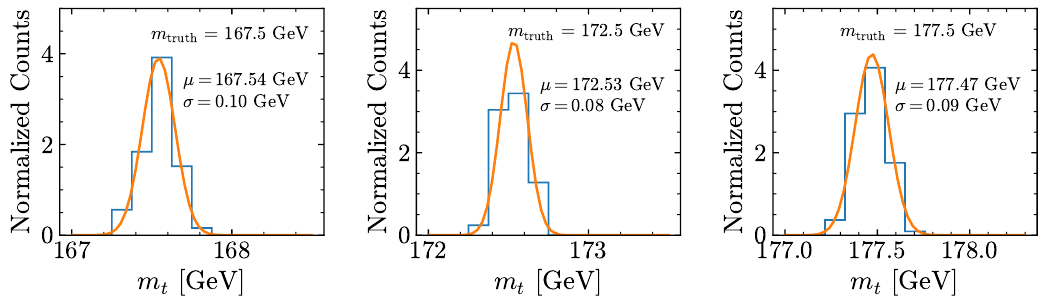
Figure 20 . The semi-leptonic template closure tests for m t =167.5 GeV, 172.5 GeV and 177.5 GeV, using our modi(cid:12)ed approach. The distribution of bootstrapped results are given by the histogram, along with an accompanying Gaussian (cid:12)t, whose mean and standard deviation are inset within each